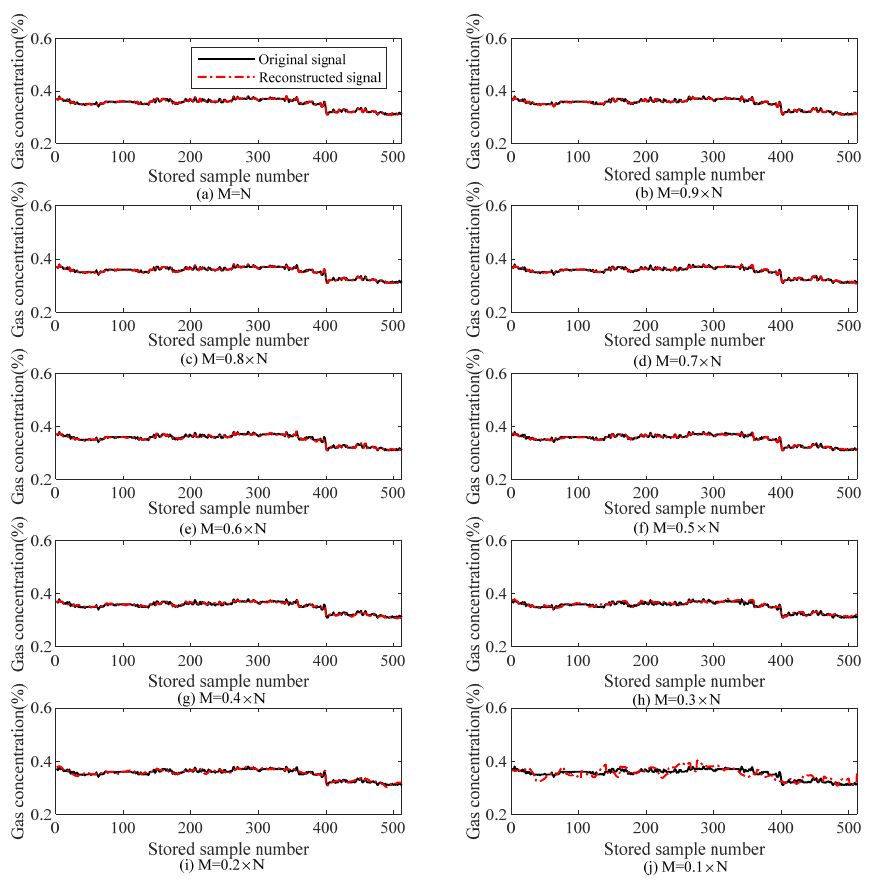
Figure 7. Compression perception and the reconstruction error of the gas steady signal (TVS-MH). Table 2. The relations of M with the reconstruction error and the computation complexity during the reconstruction of gas data under steady